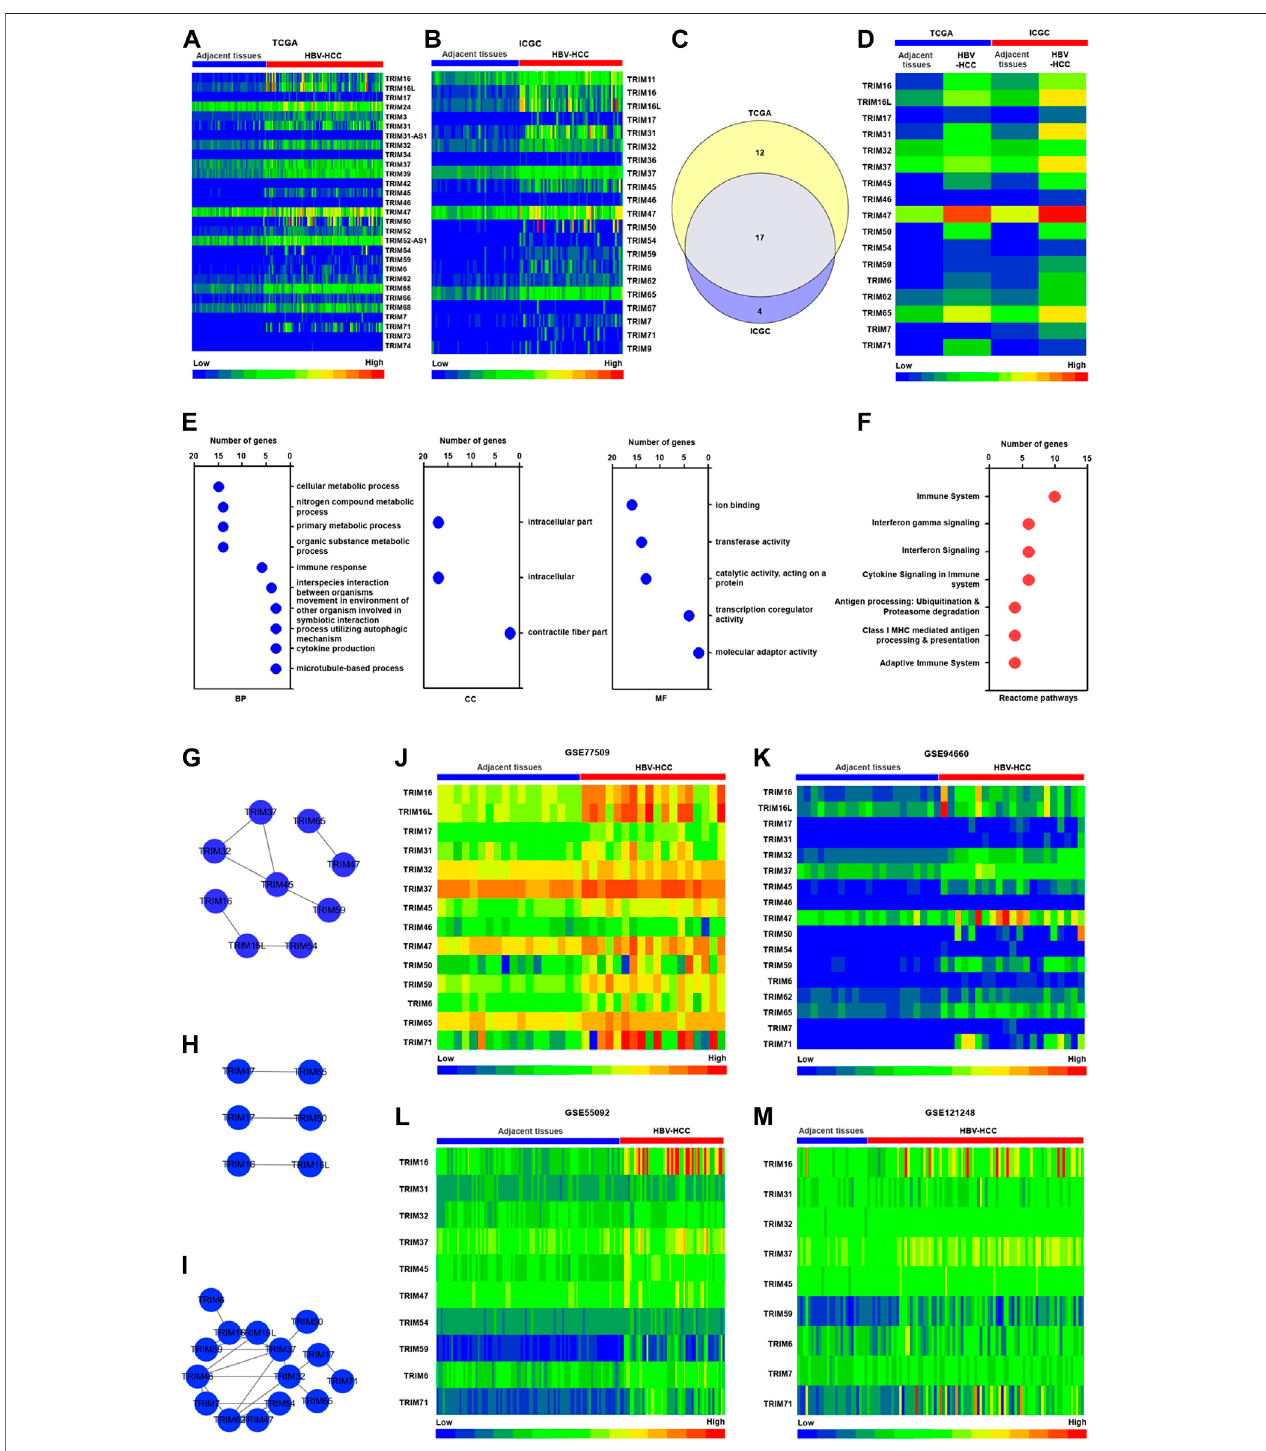
FIGURE 1 | The characteristics of TRIM gene expression in HBV-positive HCC. (A) The upregulated TRIM genes in HBV-associated HCC in the TCGA cohort. (B) The upregulatedTRIMs inHBV-positive HCC inthe ICGC cohort. (C) The common TRIM genesinHBV-positive HCC in TCGA and ICGC cohorts. (D) The expression of common TRIM genes in HBV-positive HCC in both two cohorts. (E) The GO analysis of common TRIM genes. (F) The Reactome analysis of common TRIM genes. (G) The co-expression pattern of identi fi ed TRIMs in HBV-positive HCC in the TCGA cohort. (H) The co-expression pattern of identi fi ed TRIMs in HBV-positive HCC in ICGC cohort. (I) The interaction network of identi fi ed TRIMs in HBV-positive HCC. (J) The expression of identi fi ed TRIMs in the GSE77509 cohort. (K) The levels of identi fi ed TRIMs in the GSE94660 cohort. (L) The expression of identi fi ed TRIMs in the GSE55092 cohort. (M) The expression pattern of identi fi ed TRIMs in the GSE121248